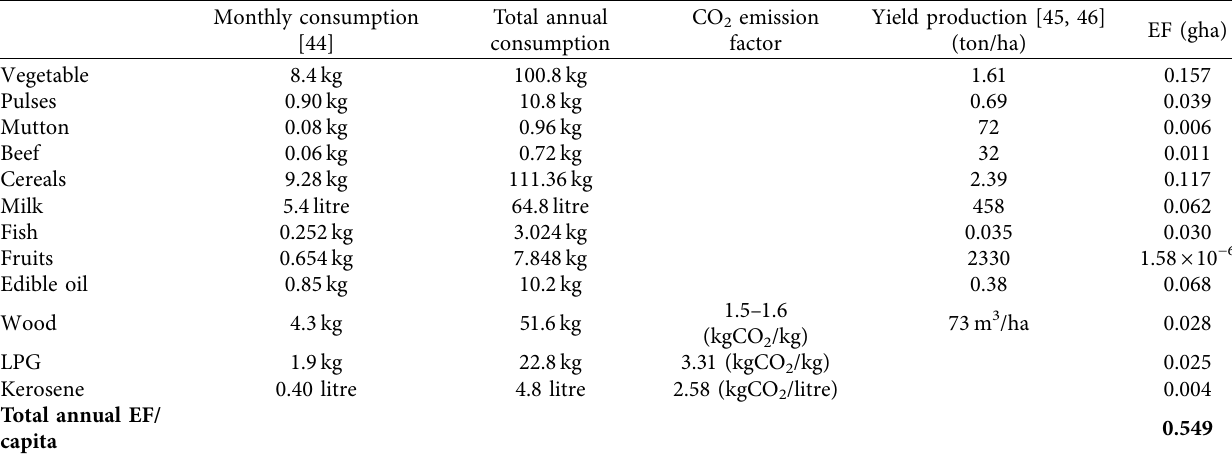
Table 4: Equivalence factor ( e Bioproductive